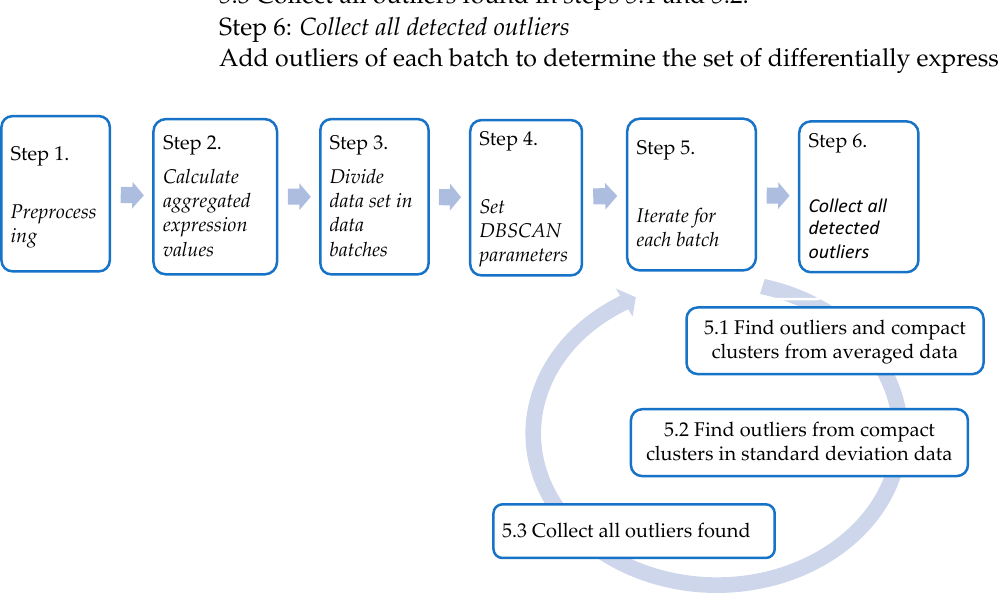
Figure 3. The procedure of the iterative clustering method for gene expression differentiation.